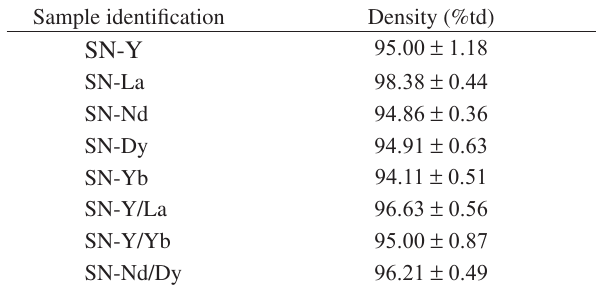
Table 1. Composition of the different silicon nitride-based ceramics (wt. (%)). Sample Table 2. Density of the silicon nitride-based ceramic